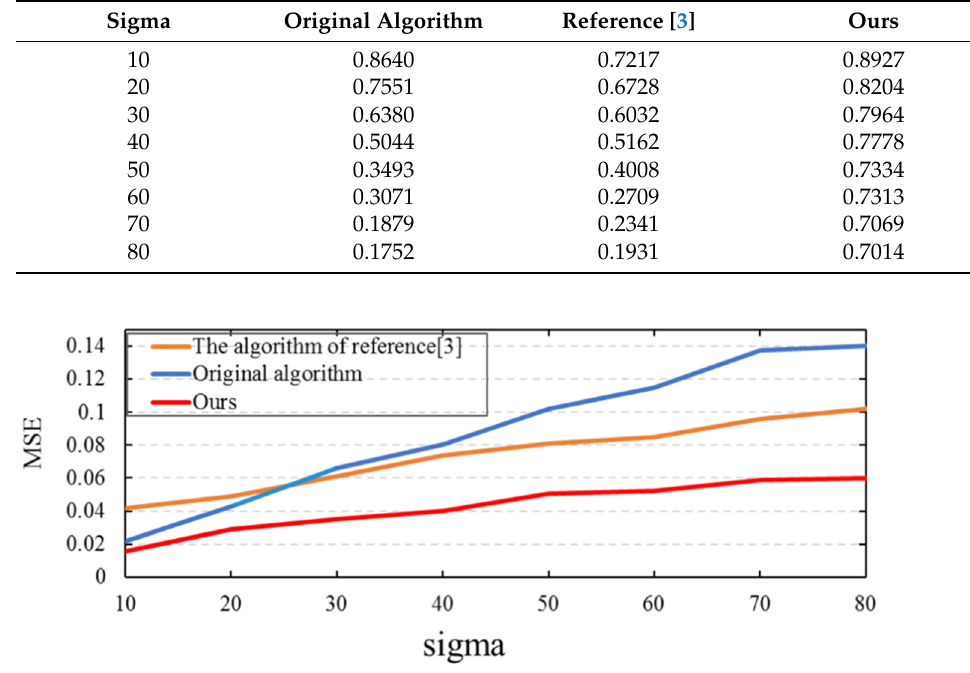
Figure 6. MSE line chart of the three algorithms for the Monarch image.